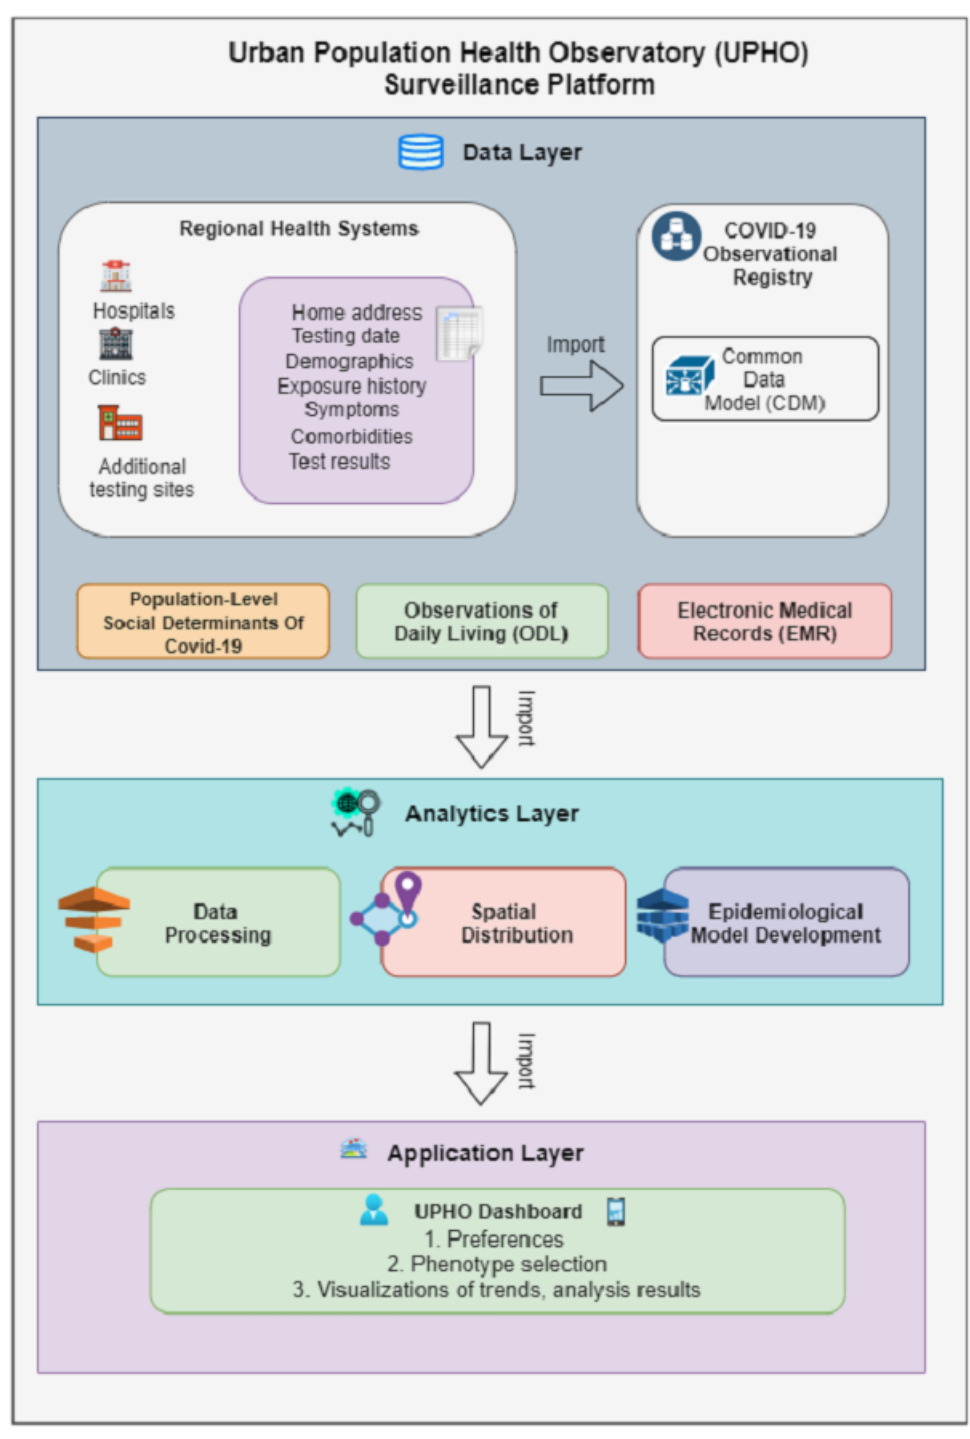
Figure 2. Layered architecture of the Urban Population Health Observatory platform from data to